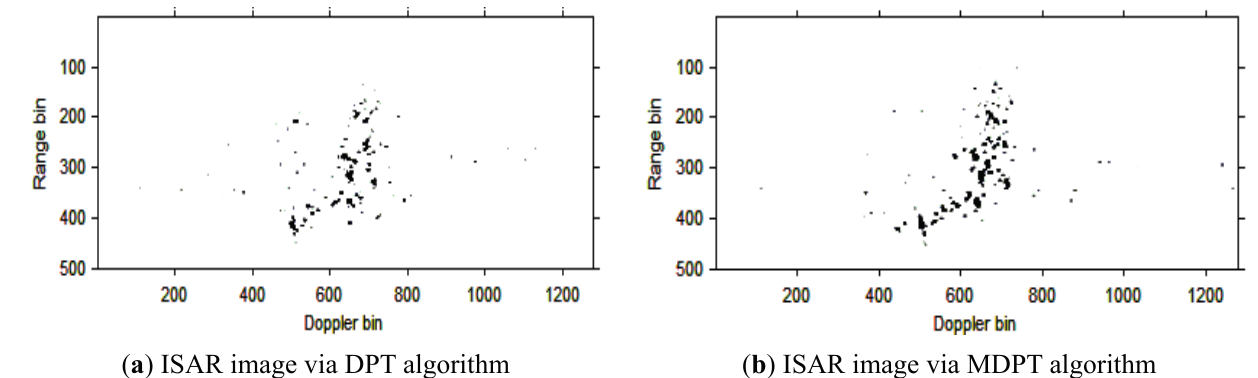
Figure 9. ISAR images at time t = 1.20 s based on DPT and MDPT algorithms.